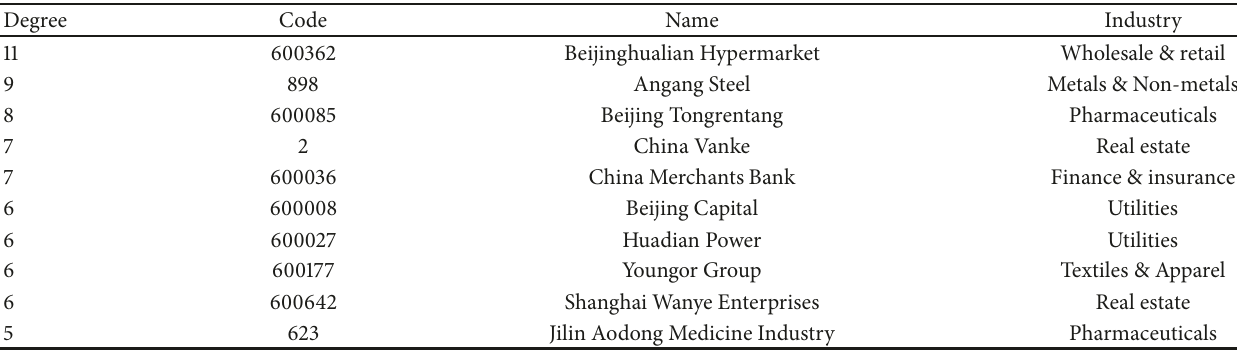
Table 10: In this table, we present the top 10 stocks with the largest degrees in the MST of CSI163. As is shown, the top 10 stocks are diverse in industry sectors which represents 1 Wholesale & retail stock, 1 Metals & Non-metals stock, 2 Pharmaceuticals stocks, 2 Real estate stocks, 1 Finance & insurance stock, 2 Utilities stocks, and 1 Textiles & Apparel stock. Degree Code